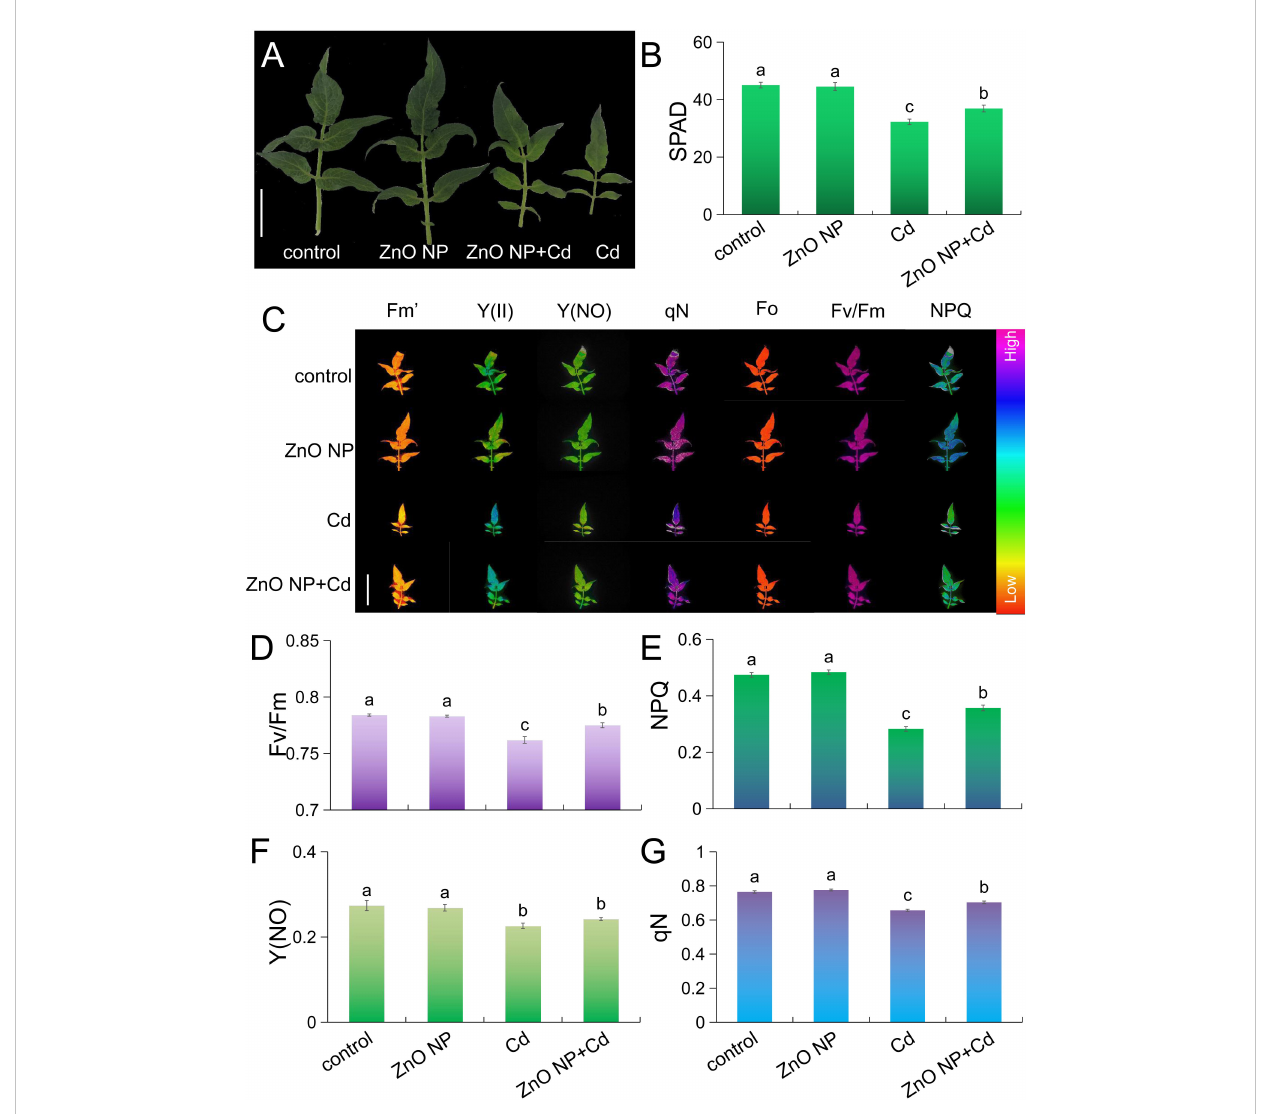
FIGURE 2 ZnO NPs improve photosynthesis in Cd-treated tomato seedlings. (A) Representative leaf images. (B) SPAD values (bar = 20 mm). (C) Representative chlorophyll fl uorescence images and (D – G) quanti fi cation of Fv/Fm (D) , NPQ (E) , Y (F) and qN (G) . Bar = 50 mm. Error bars represent the ± SEs (P < 0.05), and different letters indicate signi fi cant differences ( P < 0.05 according to Tukey ’ s